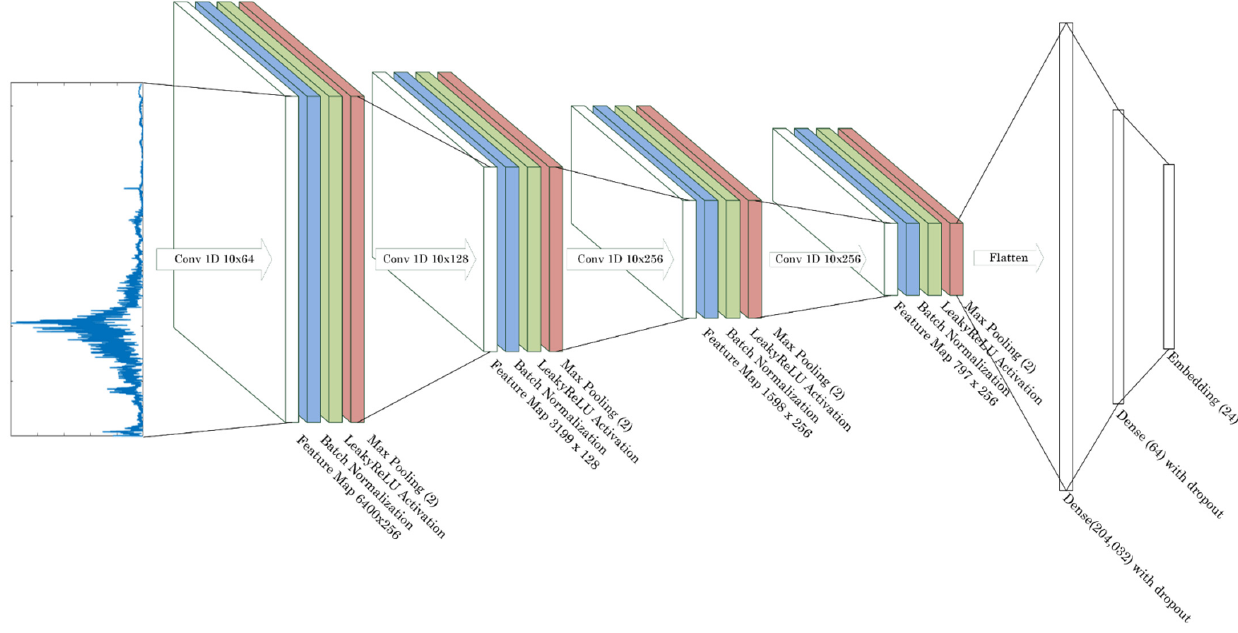
Figure 7. Sequential 1D CNN architecture.